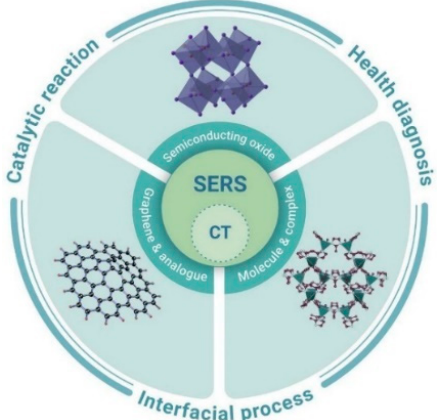
Figure 6. Schematic representing the charge-transfer (CT) induced SERS. The non-metal SERS substrates, including numerous types of semiconducting materials, such as semiconductor oxide, graphene and analogue, etc., were introduced with boosted SERS sensitivities. The promising applications include catalytic reaction, interfacial process, and health diagnosis, etc. Reprinted from Ref. [93] with permission from The Innovation.